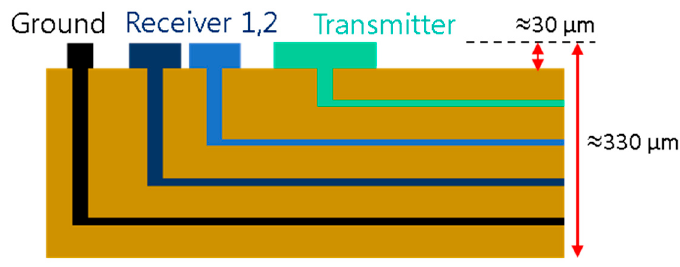
Figure 9. Cross-sectional view of the FPCB.